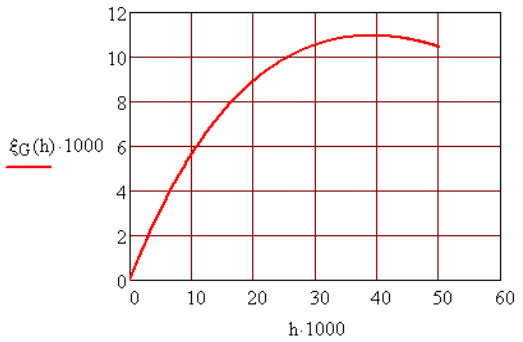
Figure 9. Optimizing the construction of the rotor from the dependency 𝜉 𝐺 = 𝜉 𝐺 (ℎ) .